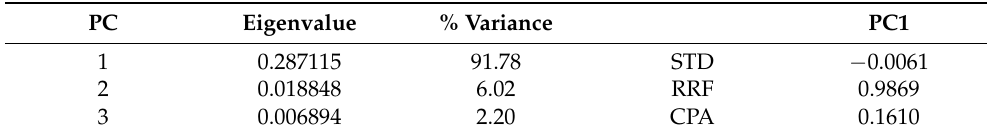
Figure 4. Principal Component Analysis of STD, RRF and PCA. National Parks are shown in red, Natural Parks in orange, Natural Areas in yellow, and Natural Monuments in green. Protected Areas considered Biosphere Reserves are shown in squares. Table 1. Principal components analysis results.